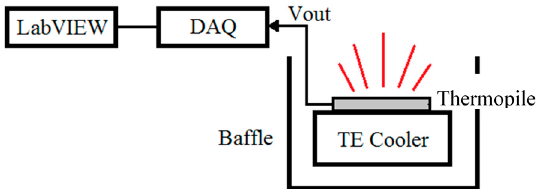
Figure 9. Measurement of radiation emission for the thermopiles.